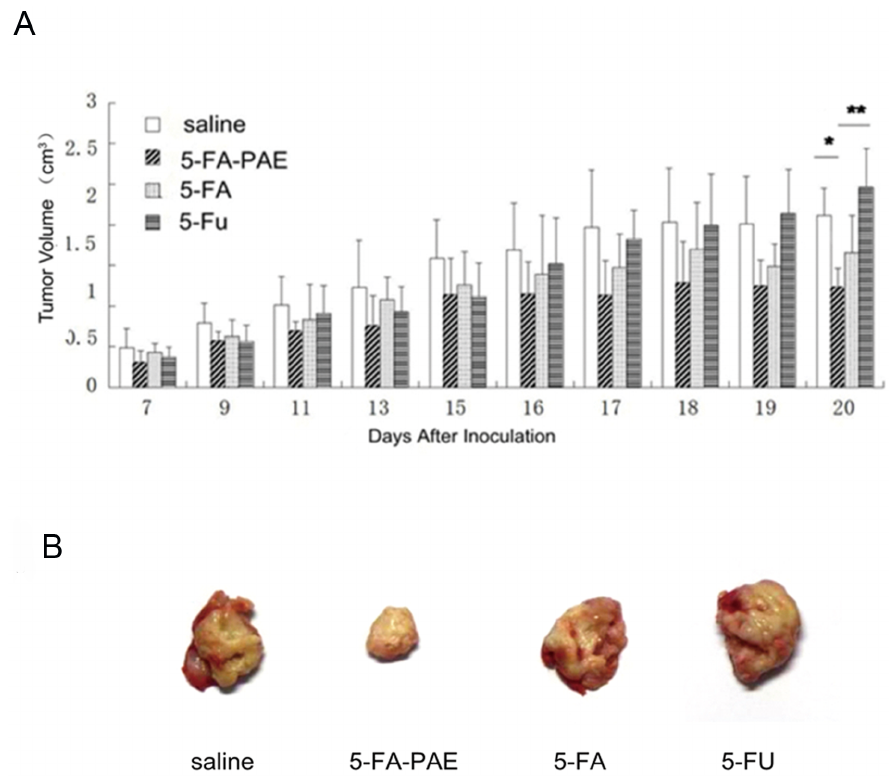
Figure 6. The antitumor effects on tumor-bearing mice. Mice were i.v injected with saline (20 mg/kg, 0.160 mmol/kg), 5-FA-PAE (284 mg/kg, 0.160 mmol/kg), 5-FA (30 mg/kg, 0.160 mmol/kg) or 5-Fu (20.47 mg/kg, 0.160 mmol/kg) on day 3, 5, 7, 9, 11, 13 and 15 after inoculation of H22 cells. On day 20, mice were sacrificed. Tumors and organs were removed and weighed. (A) The tumor volumes after inoculation (n=6–12). * p , 0.05, ** p , 0.01. (B) Images of tumors in tumor-bearing mice on day 20 after inoculation of tumor cells (n=6).